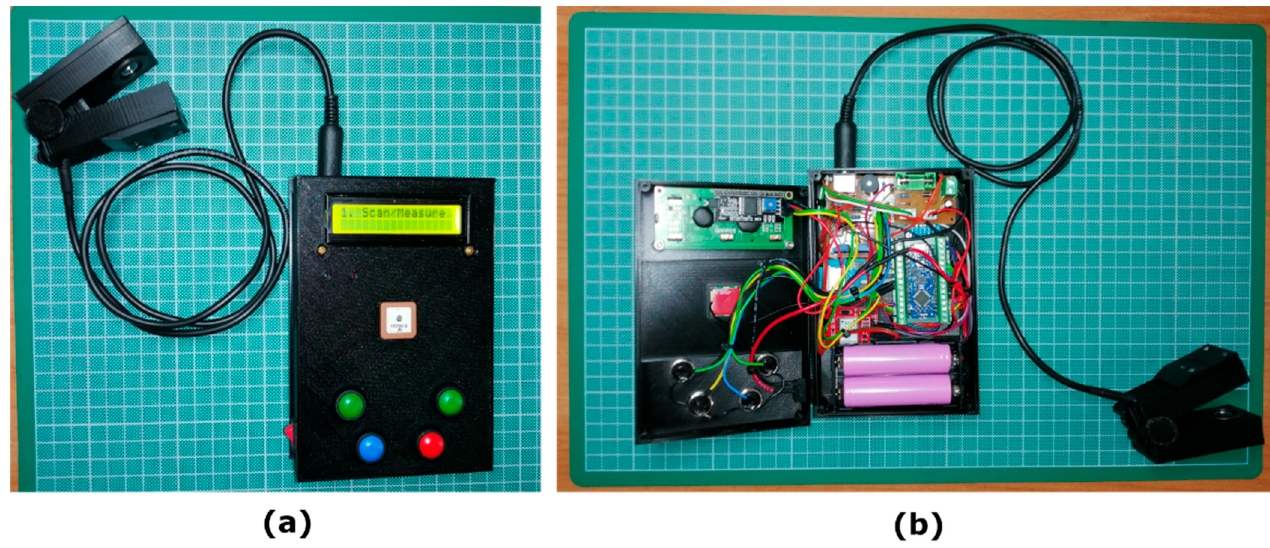
Figure 1. The low-cost chlorophyll meter presented in this work: external ( a ) and internal view ( b ).